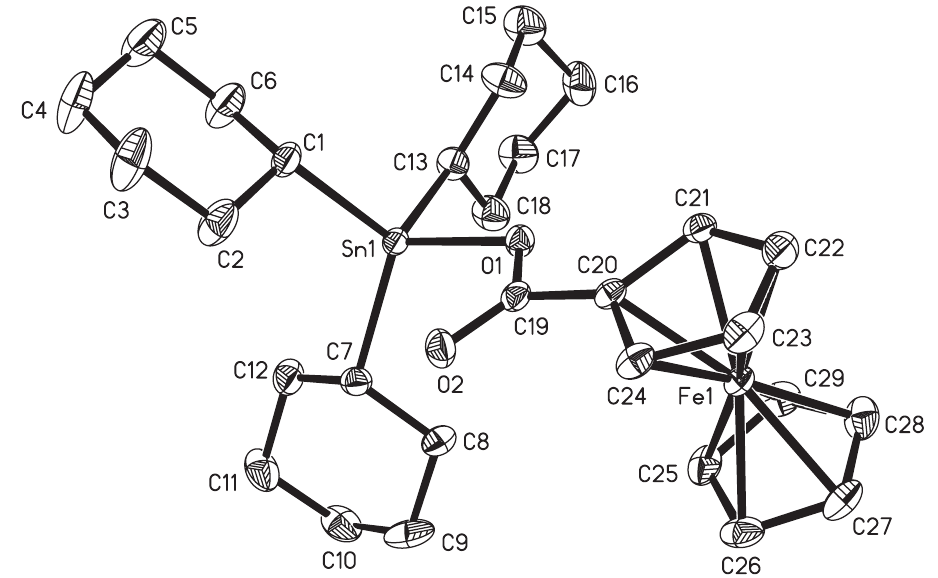
Figure 1 The molecular structure of 1 ; hydrogen atoms are omitted for